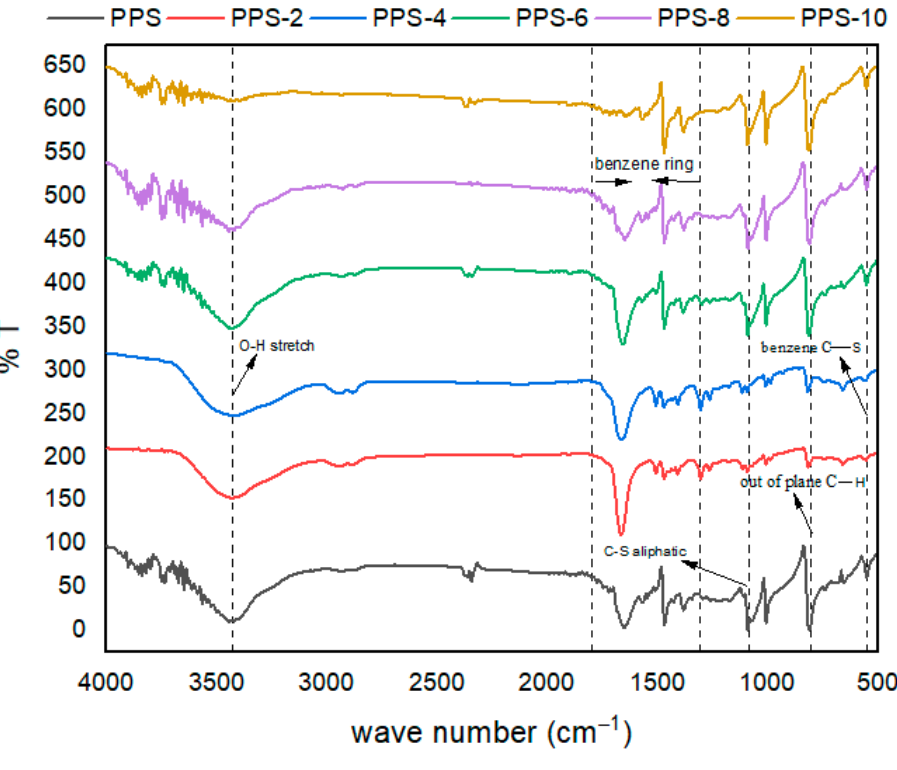
Figure 6. FTIR spectra of PPS@BC nanocomposites.